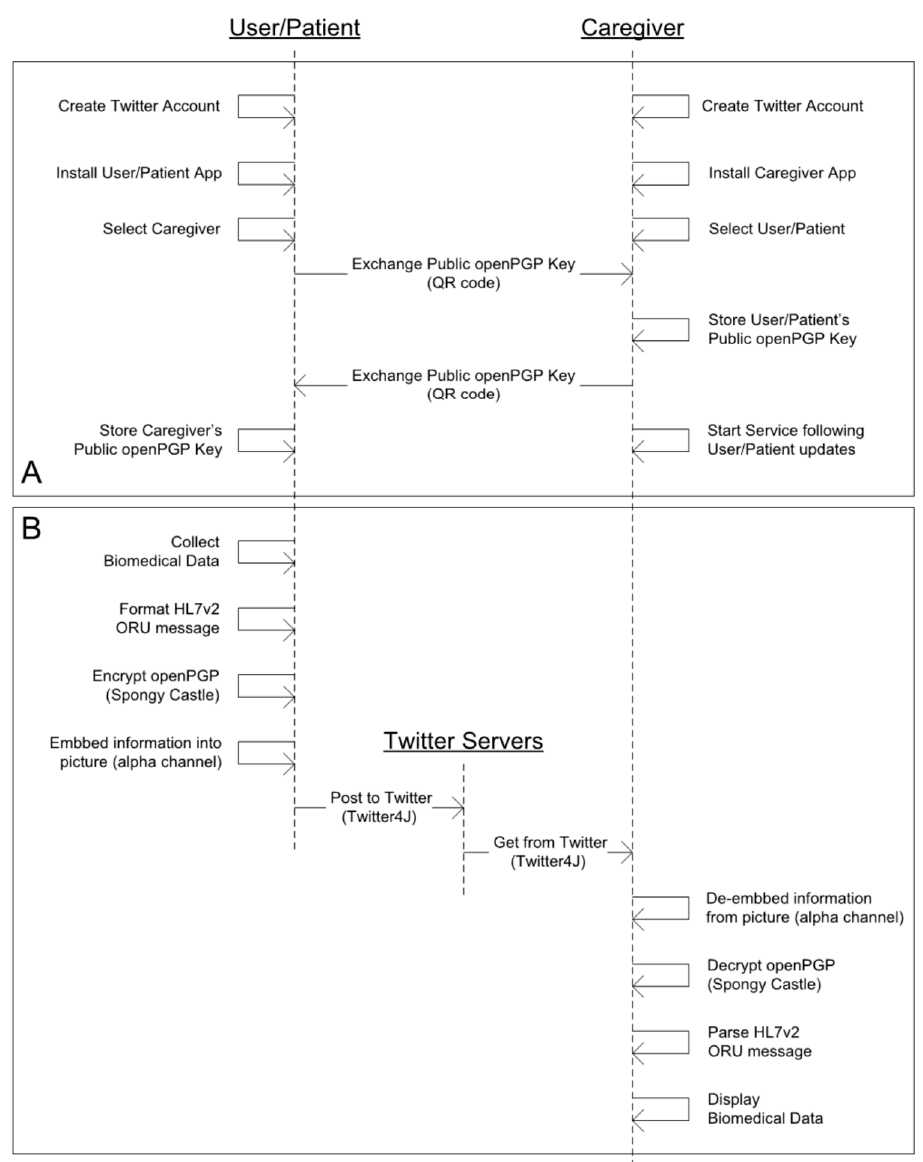
Figure 5. Actions performed and communication flow among the actors. Section ( A ) is the configuration phase. Section ( B ) is the operation phase and it is performed every time new measures are sent.